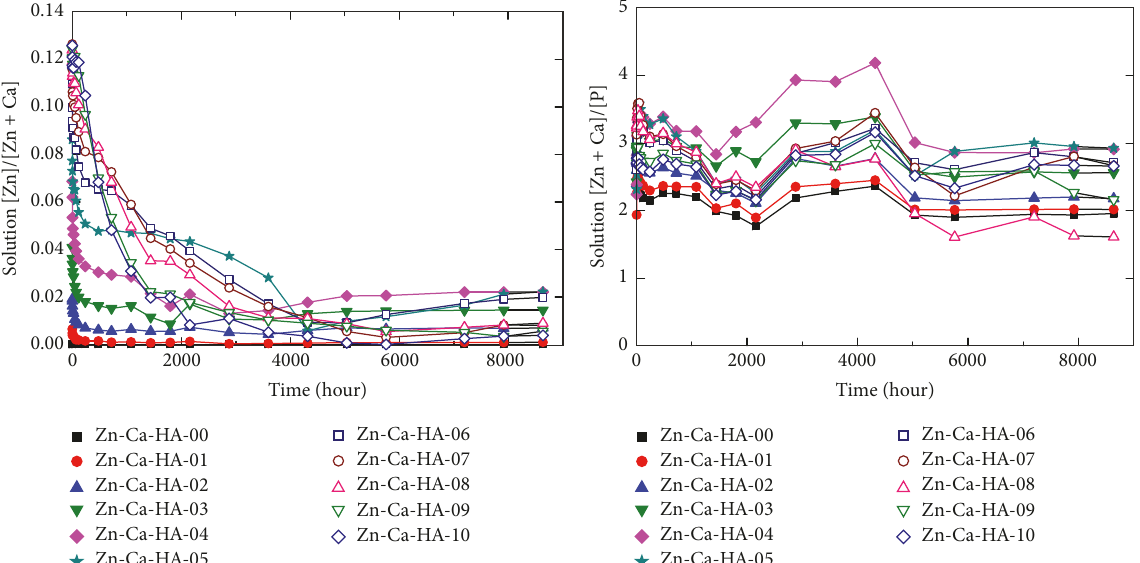
Figure 6: Change of the solution [Zn]/[Zn + Ca] and [Zn + Ca]/[P] molar ratios with time for the dissolution of the Zn-substituted hydroxylapatites [(Zn Ca 1− ) 5 (PO 4 ) 3 OH] at 25 ∘ x x